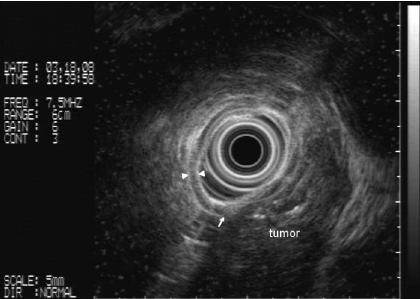
Figure 2 - Endotracheal ultrasound: tracheal mucosa, tracheal submucosa, and tracheal adventitia with arrows. Tracheal invasion by esophageal tumor defined by the interruption of the adventitia and submucosa of the posterior tracheal wall (major